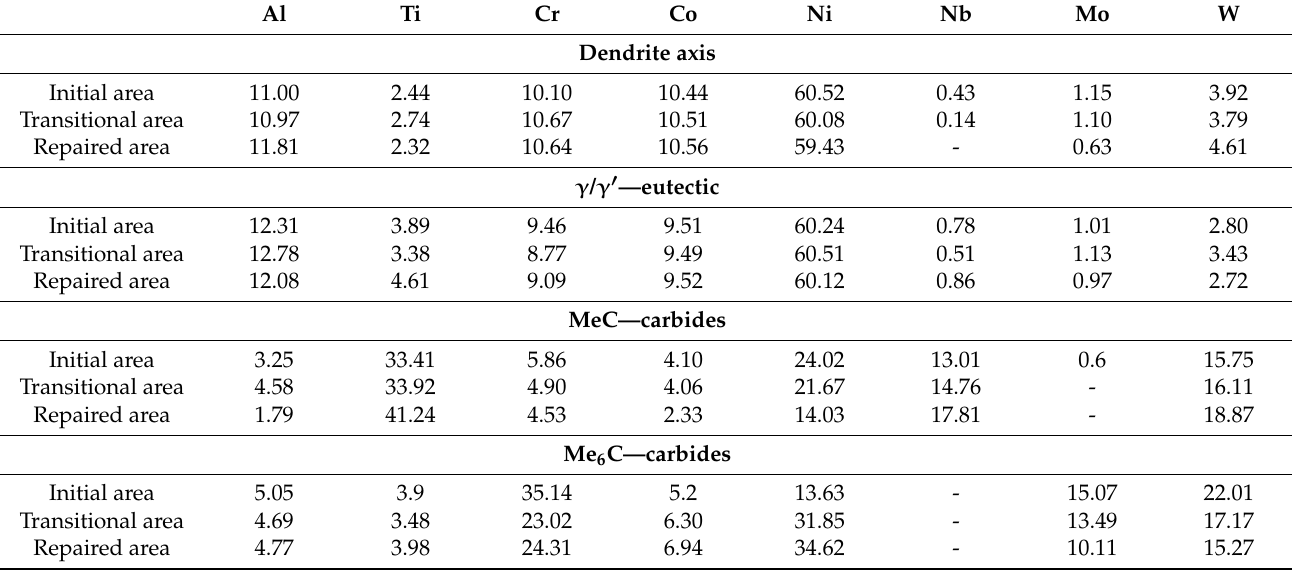
Table 2. Chemical composition of different structural-phases elements (at.%).